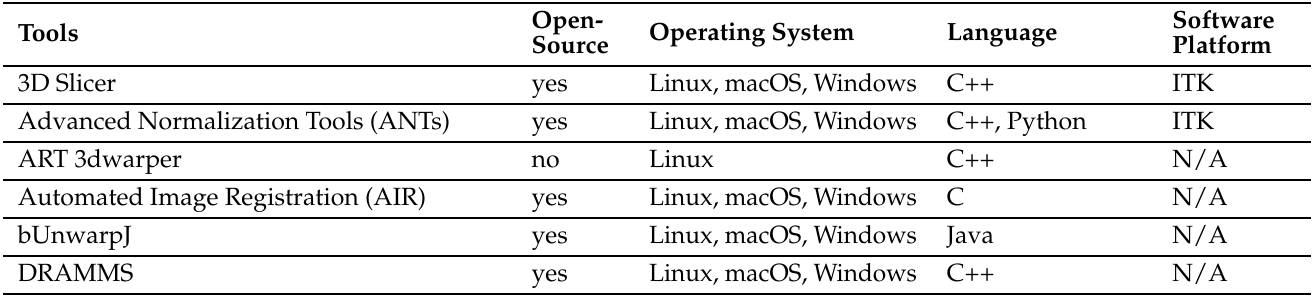
Table 5. Image fusion